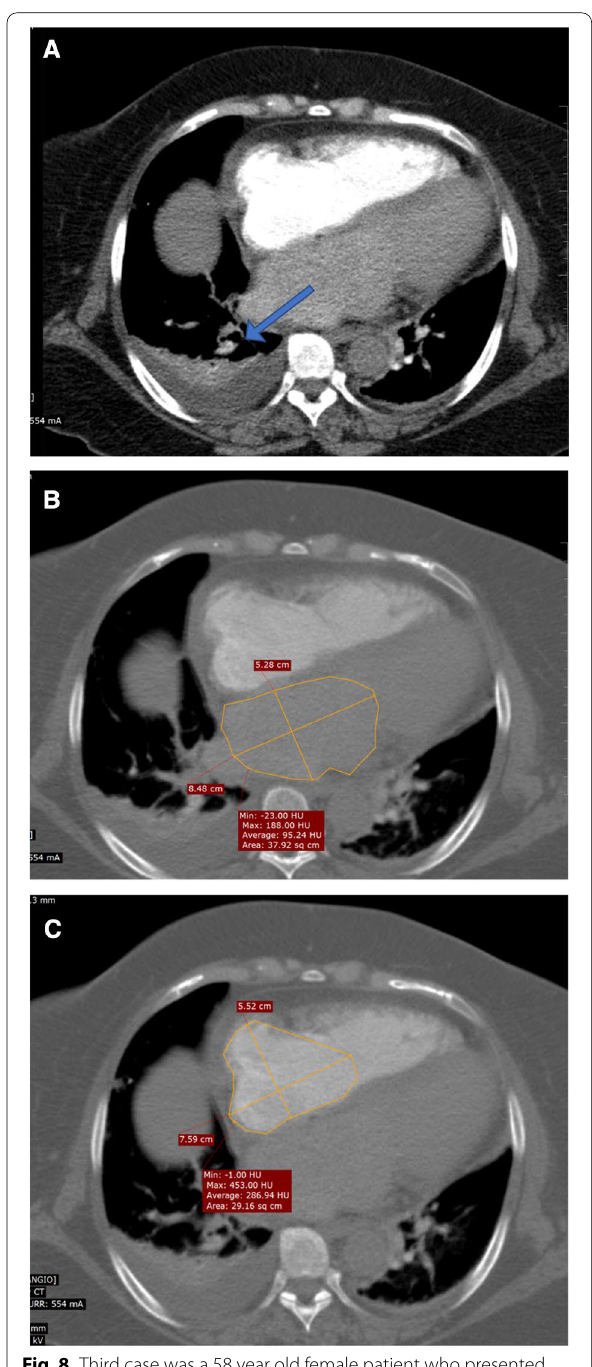
Table 10 Correlation of atrial parameters with Qanadli Index